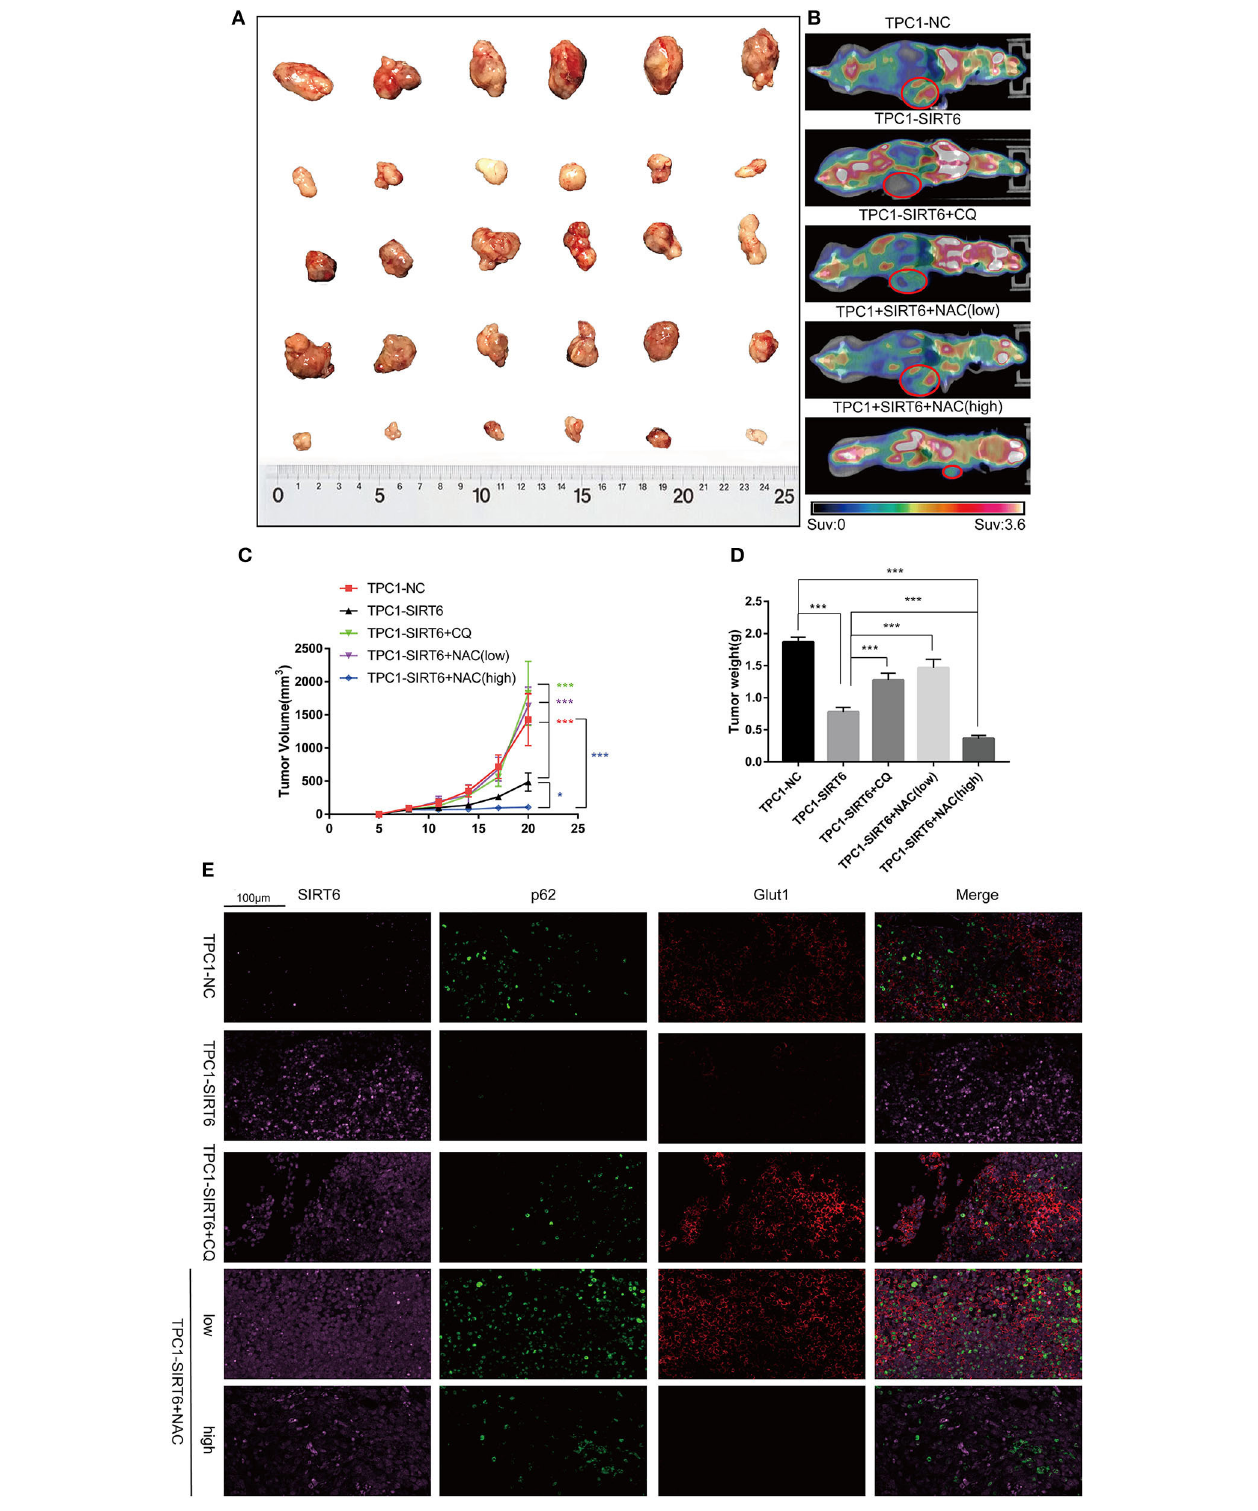
FIGURE 5 | CQ and NAC promoted the growth of SIRT6-overexpressing PTC cells in vivo . (A) Subcutaneous xenografts derived from each group: TPC1-NC cells, TPC1-SIRT6 cells, TPC1-SIRT6 cells treated with CQ, and TPC1-SIRT6 cells treated with NAC (low: 50 mg/kg, high: 150 mg/kg). (B) PET/CT images captured before the sacrifice of mice in each group described above. (C) Tumor growth curve of each group described above. (D) Tumor weight of each group described above. (E) IF staining showing the expression and location of SIRT6, P62, and GLUT1 in each group described above (* p < 0.05 and *** p < 0.001).